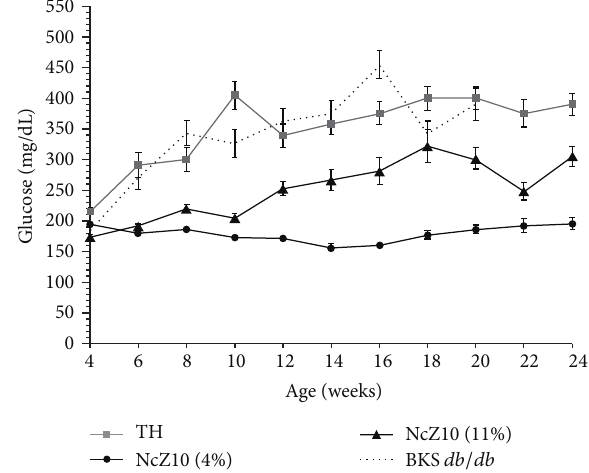
Figure 2: Development of hyperglycemia (defined as nonfasting serum glucose ≥ 250mg/dL) in the same cohorts shown in Figure 1. Data are means ±